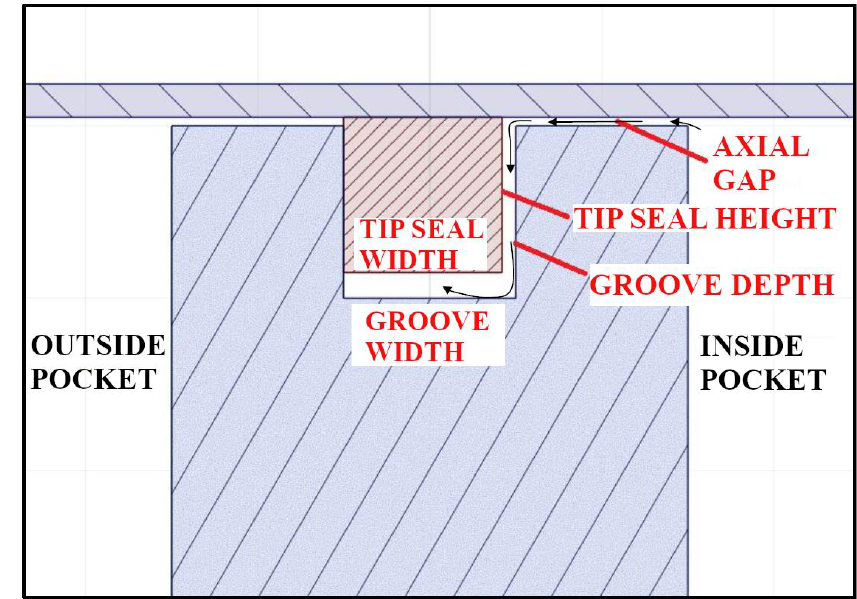
Figure 4. PumpLinx approach to axial gap modelling.